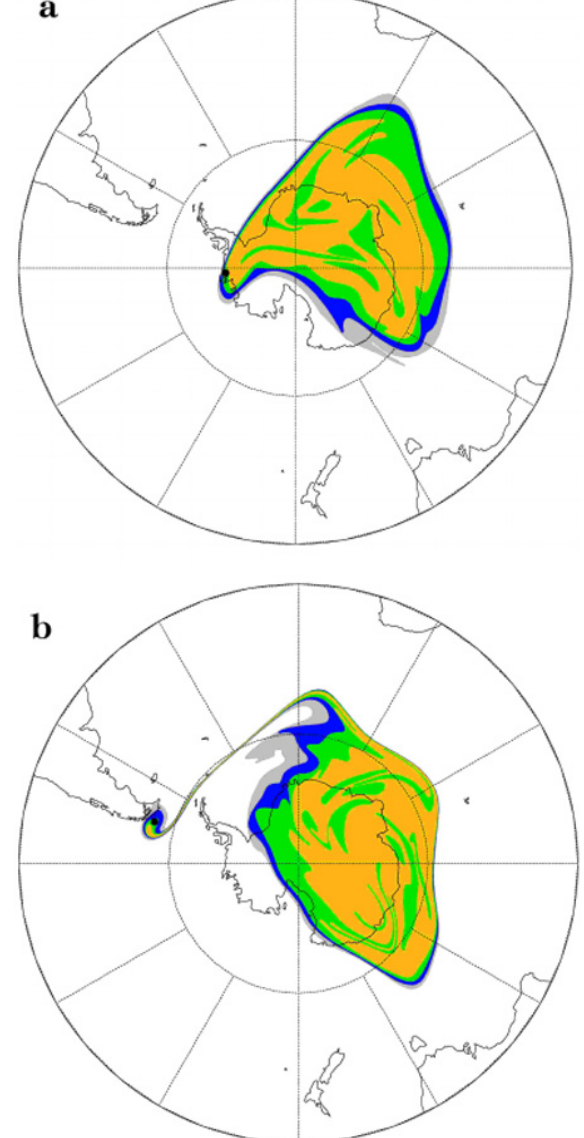
Fig. 5. Distributions of the isentropic potential vorticity field re- constructed by the CAS method at 500K level: (a) on day 22 and (b) on day 25. The contours represented have a magnitude values of 28, 32, 36 and 40PVU. The black dot indicates the location of the